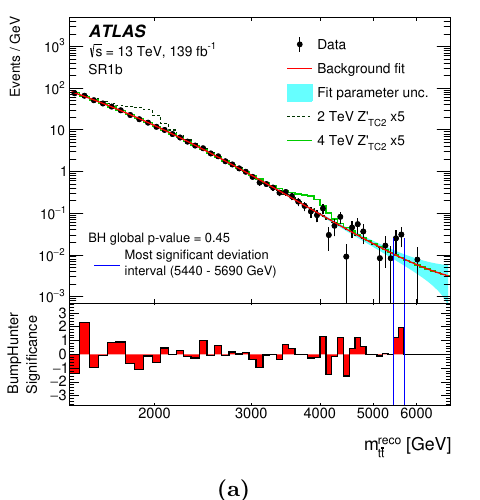
Figure 3. Observed m reco distributions in data for (a) SR1 b and (b) SR2 b , shown together with t (cid:22) t the result of the (cid:12)t with the three-shape-parameter function. The shaded bands around the (cid:12)ts indicate the e(cid:11)ect of the (cid:12)t parameter uncertainty on the background prediction. The bin width of the distributions is chosen to be the same as that used in the background parameterization (section 5.2). The predicted Z 0 signal distributions with masses of 2 and 4 TeV (multiplied by a TC2 factor of 5) are superimposed on the background prediction. The lower panel shows the signi(cid:12)cance of data with respect to the background prediction from the (cid:12)t, calculated in continuous mass intervals scanned over the binned m reco distributions. The two vertical lines extending between the t (cid:22) t upper and lower panel represent the most signi(cid:12)cant deviation interval. The global p -value of the interval is 0.45 (0.56) for SR1 b (SR2 b